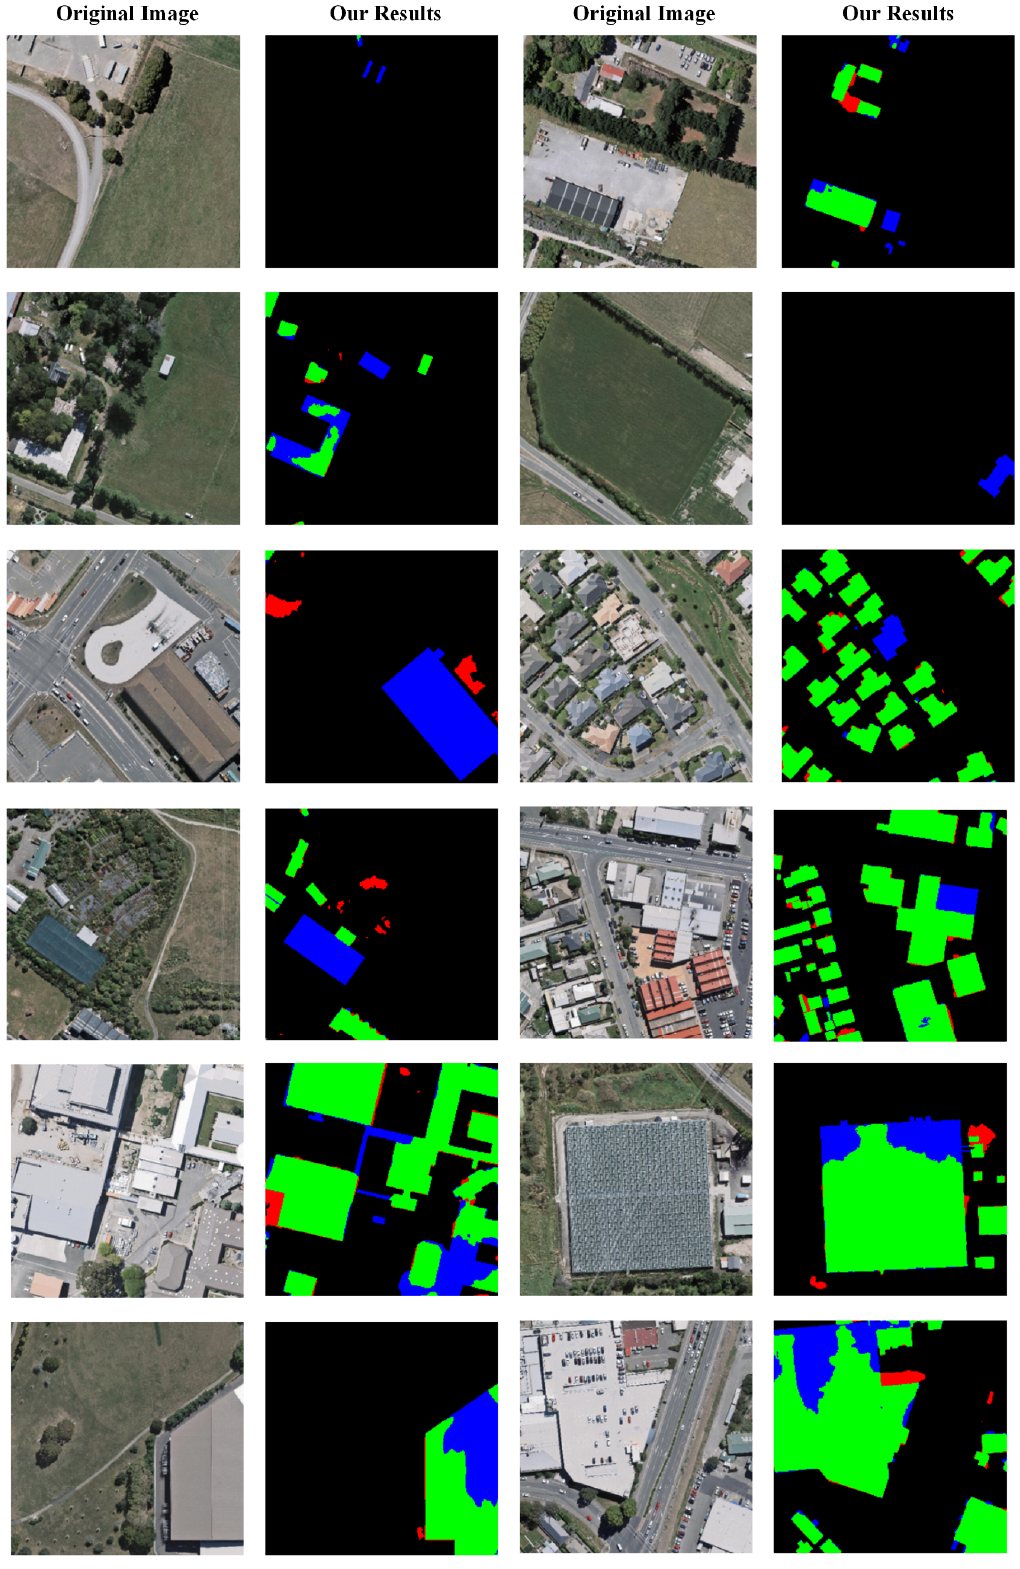
Figure 10. Major false negative exhibitions of our extraction results in the WHU dataset. The green, red and blue areas represent the right, false positive and false negative areas,